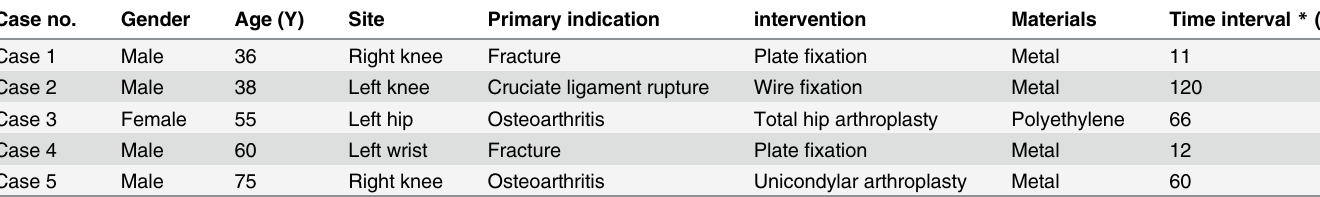
Table 3. Clinical characteristics of PVNS patients diagnosed after orthopedic interventions Case no.